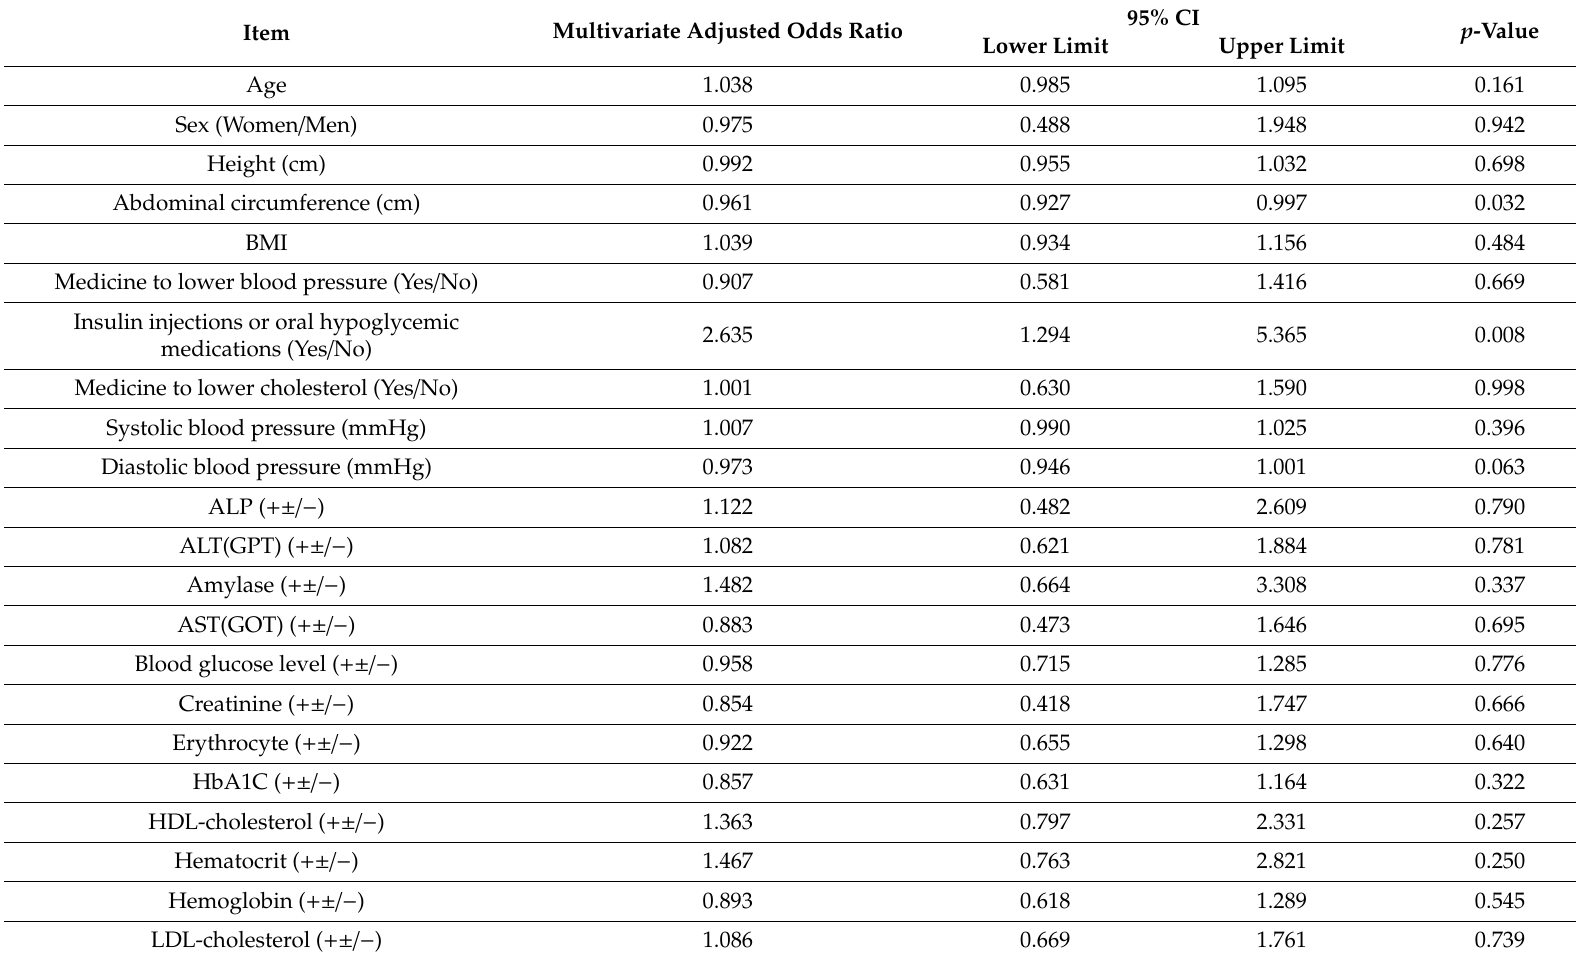
Table 3. Results of multivariate logistic regression